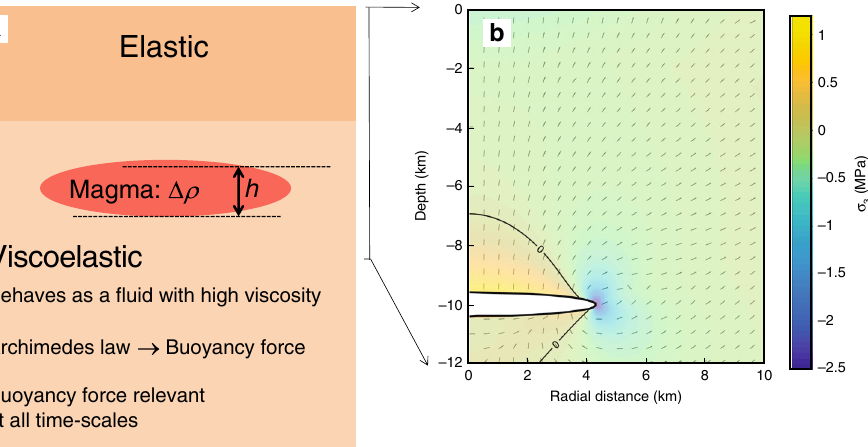
Fig. 2 Model and stress fi eld due to buoyancy. a Schematic model of a magma body residing in viscoelastic material below an elastic layer. The magma is less dense than the host rock and therefore buoyant. The density difference between magma and host rock is Δ ρ , and h is the elevation above the bottom of the magma body. b Stress due to buoyancy around a horizontal ellipsoid, with a 4.3-km semi-major axis and a 0.4-km semi-minor axis, embedded in an elastic medium with a Poisson ’ s ratio of 0.25. The density contrast is set to 270 kg/m 3 . Pressure equal to Δ ρ gh , with g being the acceleration of gravity, is applied at its boundary (Fig. 3). The colour scale shows the amplitude of the minimum compressive stress (negative values for tension) and dashes represent the direction of maximum compressive stress ( σ 1 ). The crustal volume immediately above the magma body is under compression, but the edge of the body is affected by a large tensile stress allowing for dike initiation. Above the body, the stress fi eld is similar to the one induced by overpressure resulting from magma in fl ow (Fig.